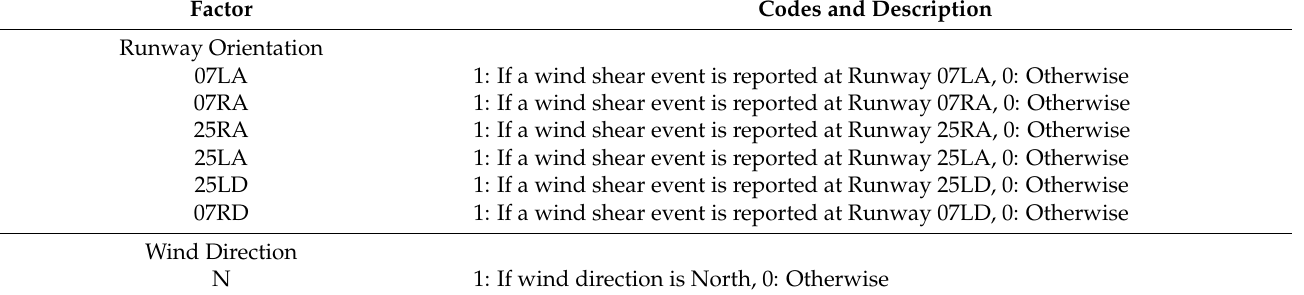
Codes and Description